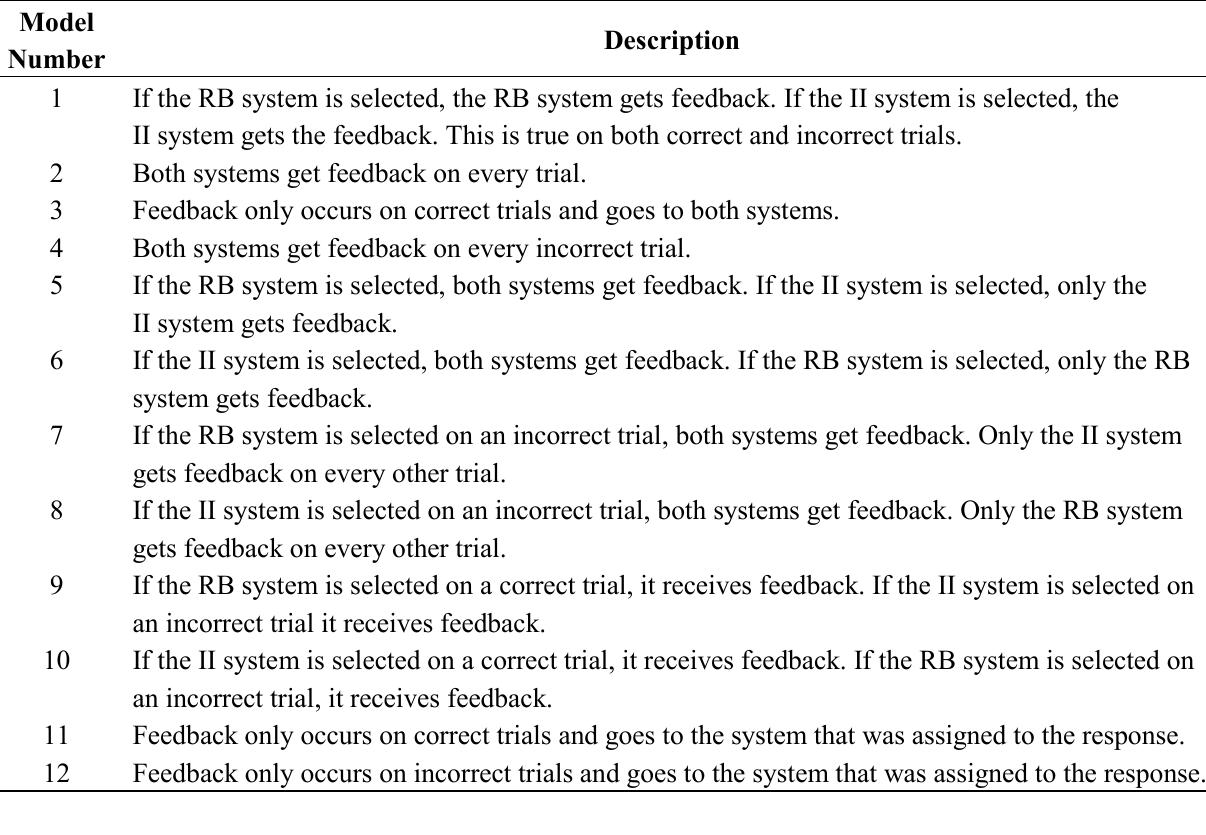
Table 2. Different feedback mechanisms for the PINNACLE